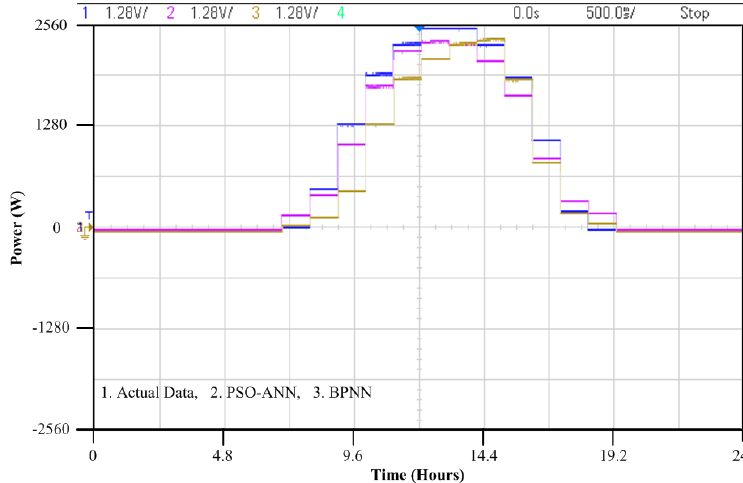
Figure 7. Forecasting result of PV power with PSO-ANN and BPNN.